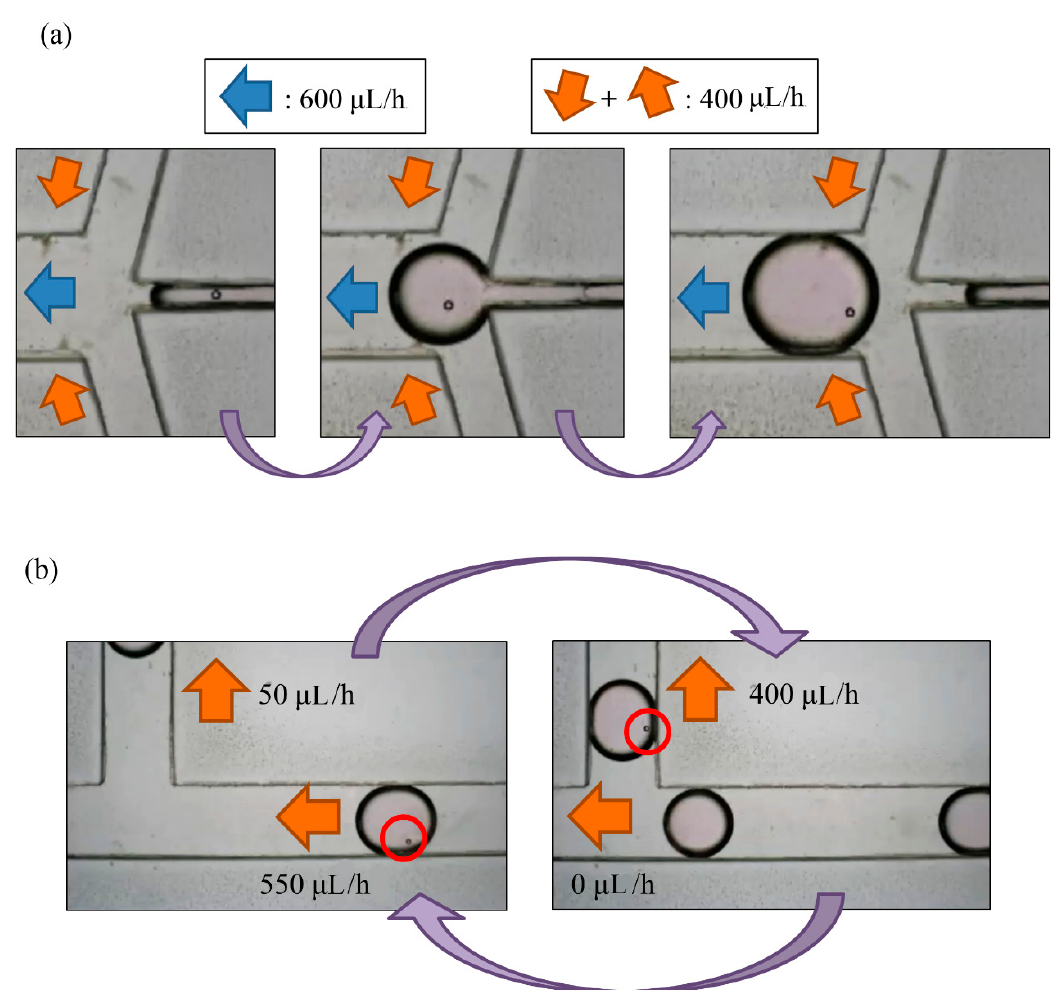
Figure 6. ( a ) A droplet with a PS bead was generated in the generating area; ( b ) the total flow rate